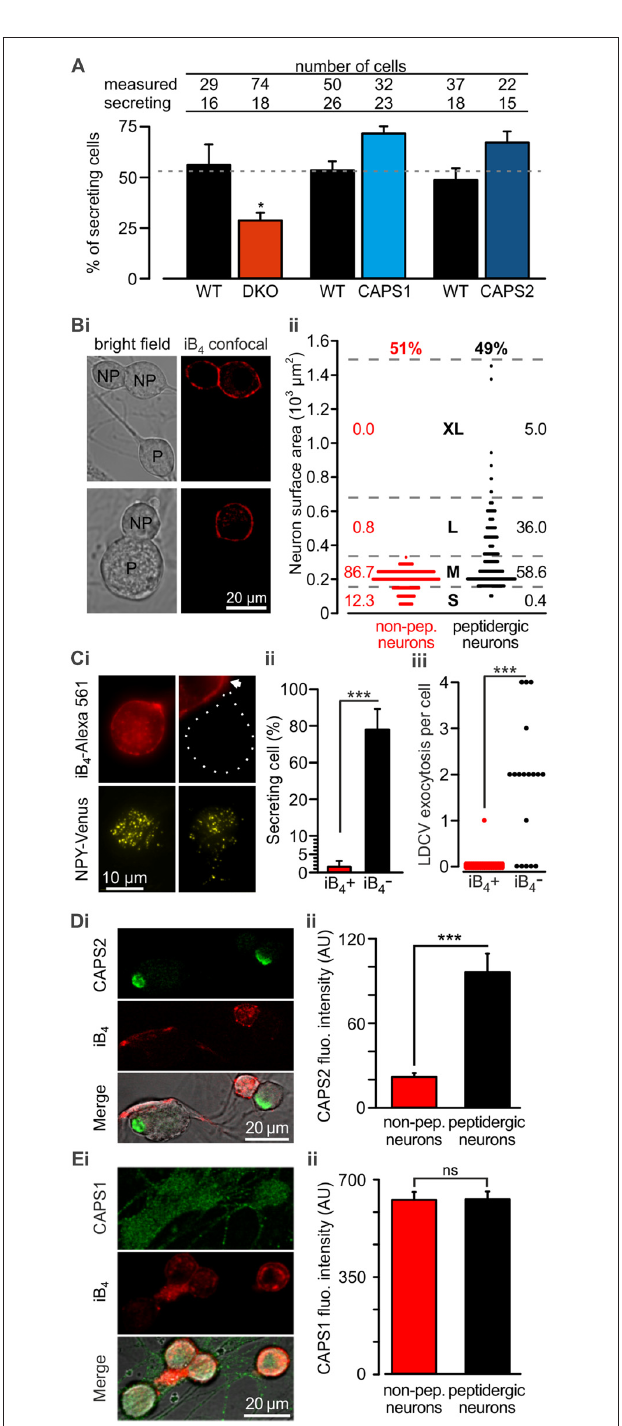
FIGURE 3 | CAPS2 is localized to the secreting peptidergic neurons. (A) Percentage of cells that released LDCVs upon field electrode stimulation in CAPS DKO, CAPS1-, or CAPS2-overexpressing neurons compared to their WT controls. The cells that responded to the stimulus with LDCV exocytosis are presented in Figure 2 . The gray dotted line corresponds to the average proportion of all responding WT controls. (N WT & DKO = 5 and 6 respectively, N CAPS1 & WT control = 5, N CAPS2 & WT control = 7; ∗ p < 0.05 Student t -test).